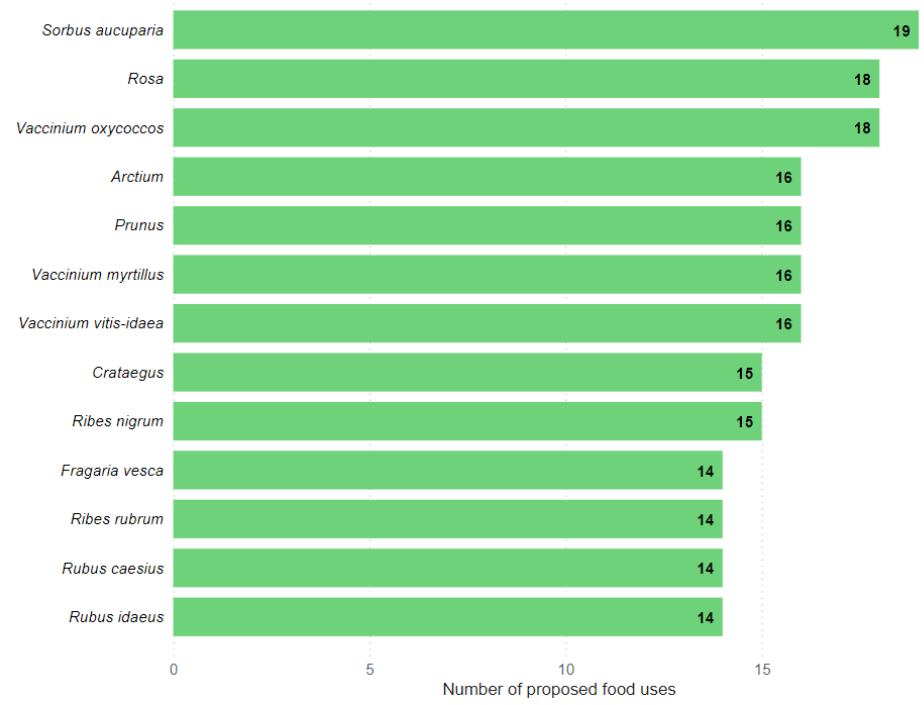
Figure 1. The top 11 plant families according to the number of proposed food use categories in all 12 books published centrally in Russian during the Soviet era.